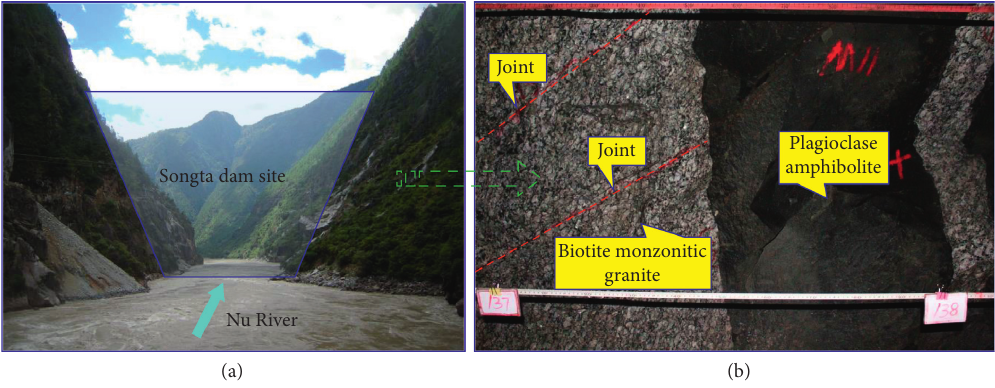
Figure 4: Geological conditions of the Songta dam